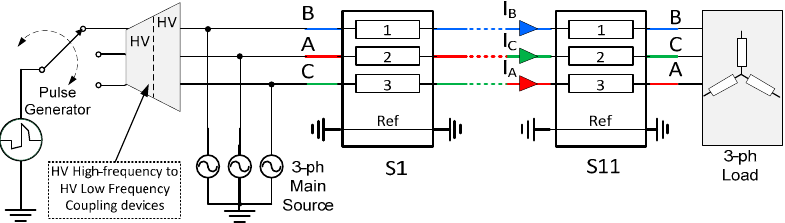
Figure 3. Principle scheme of the basic idea for the application of the TDR signal on in-service lines.